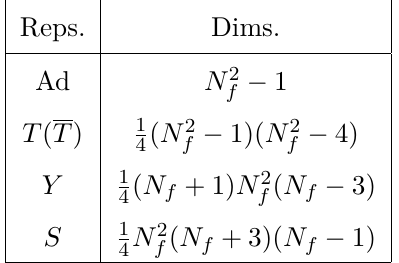
Table 1 . Representations in SU( N f ) and their